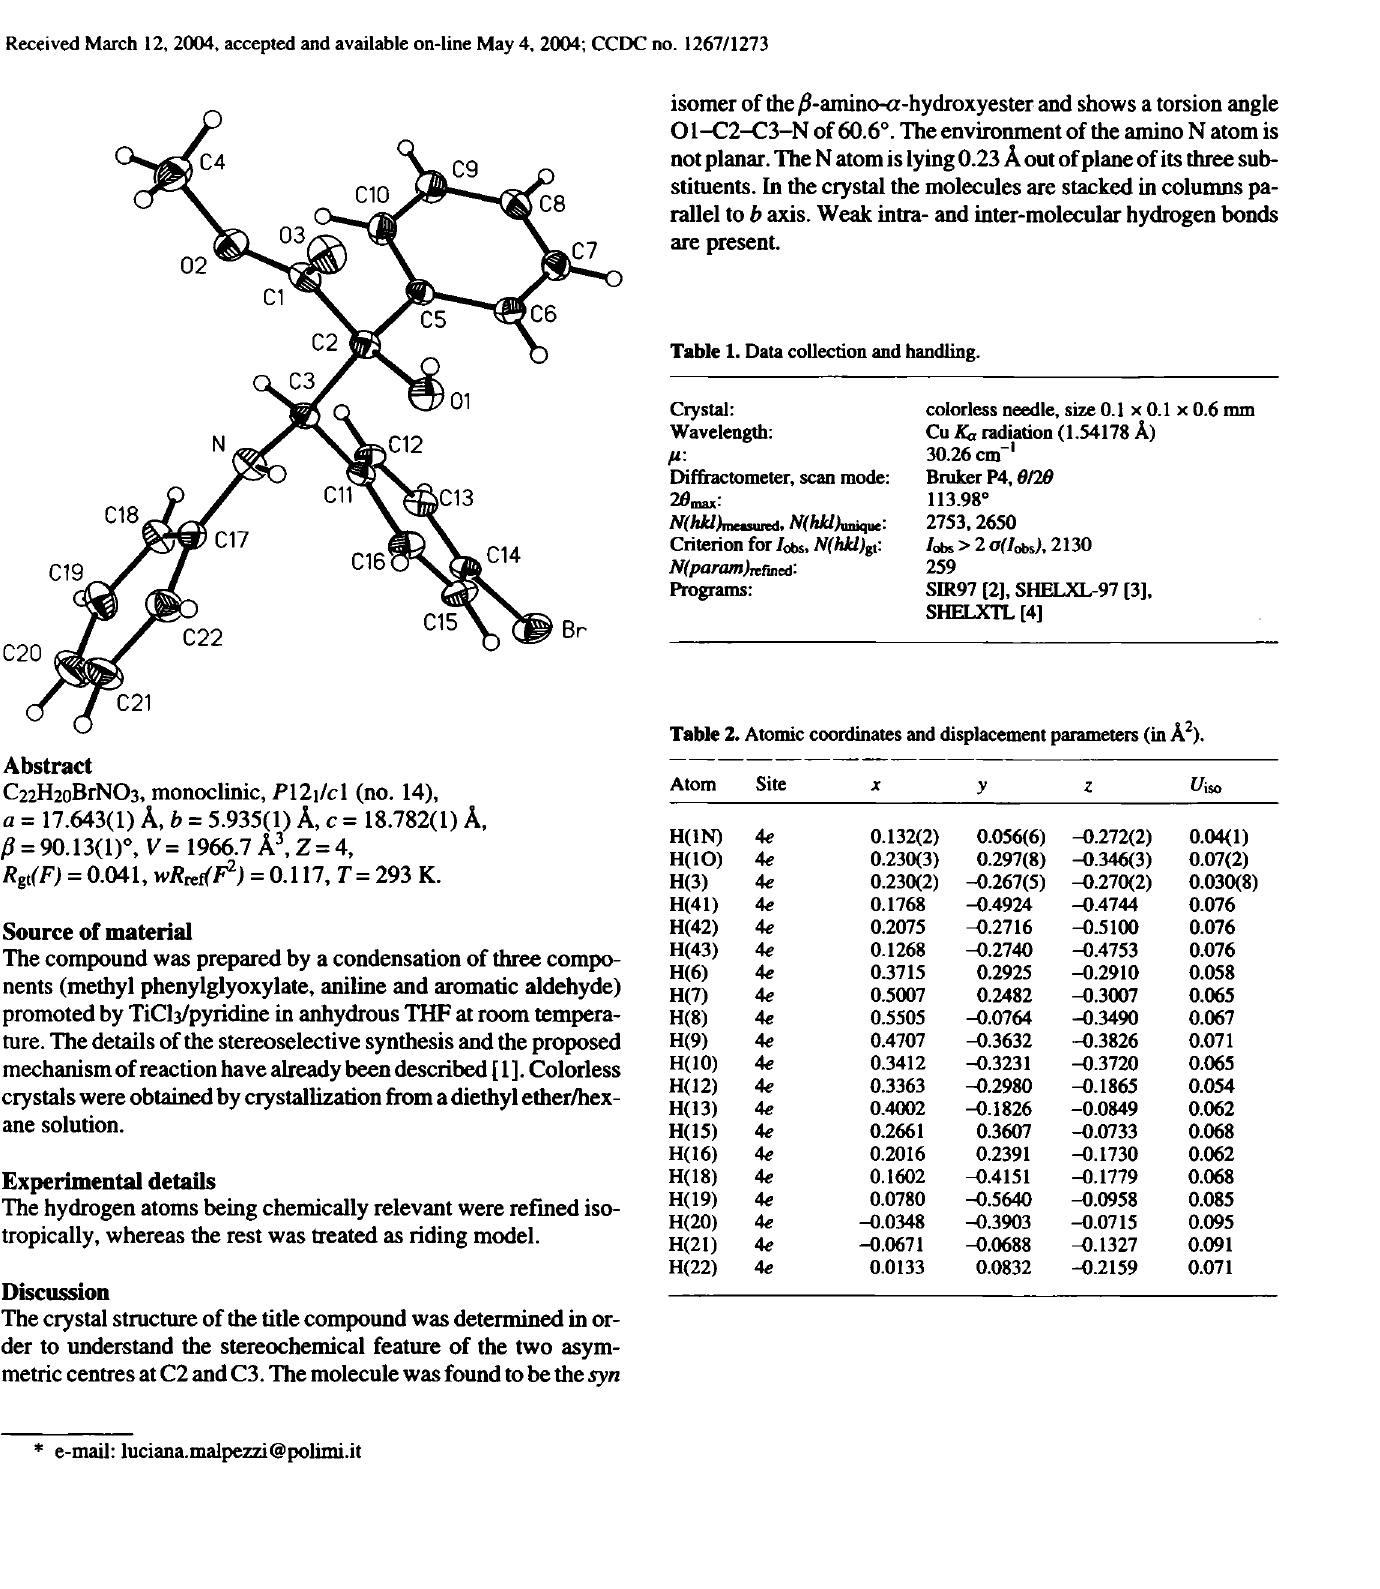
Table 1. Data collection and handling.